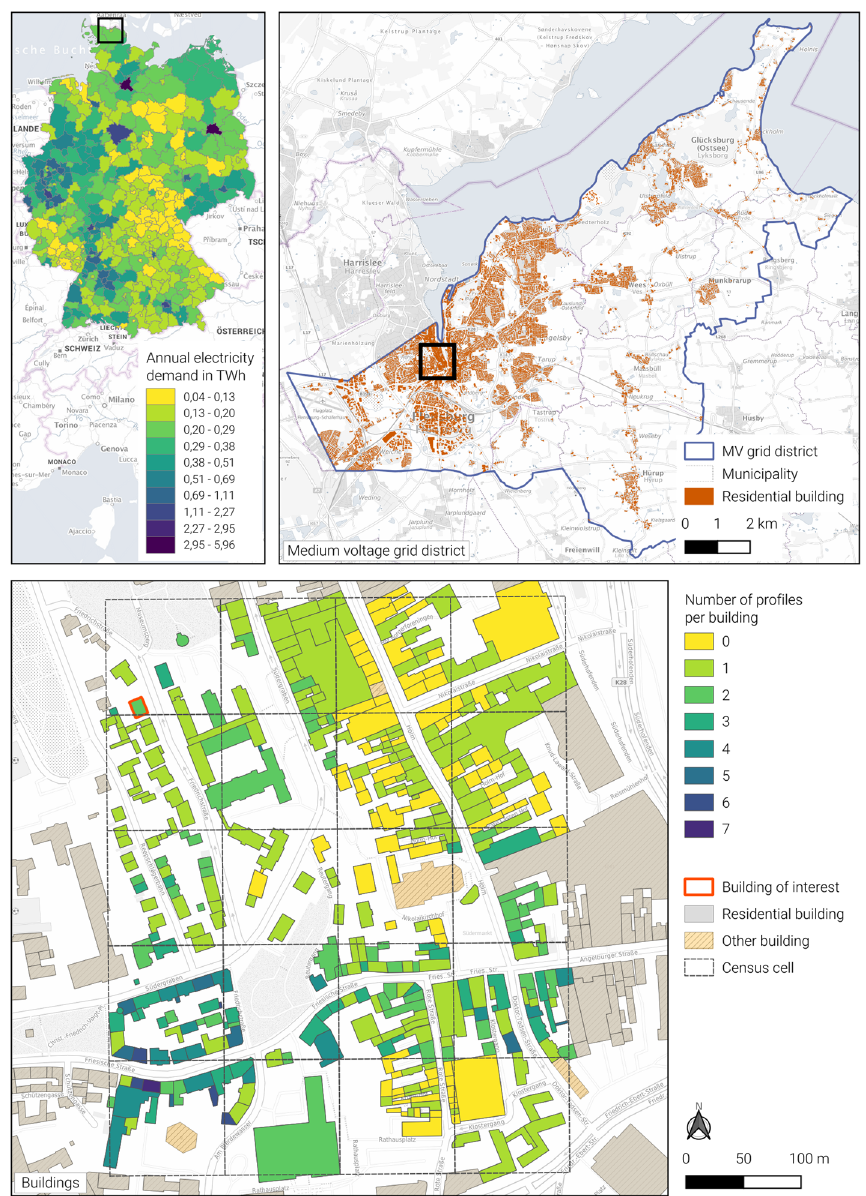
Fig. 3 Electricity demand on NUTS 3-level (upper left); Exemplary MVGD (upper right); Study region in Flensburg (20 Census cells,